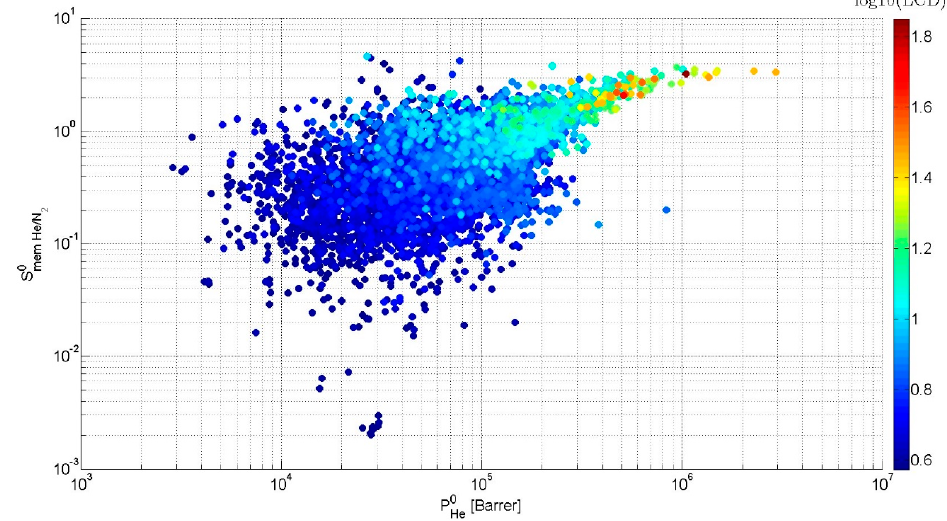
0 P ) deter- S ) on helium permeability ( 0 ) on helium permeability ( P 0 ) determined He / mem He N mem He / N 2 He 2